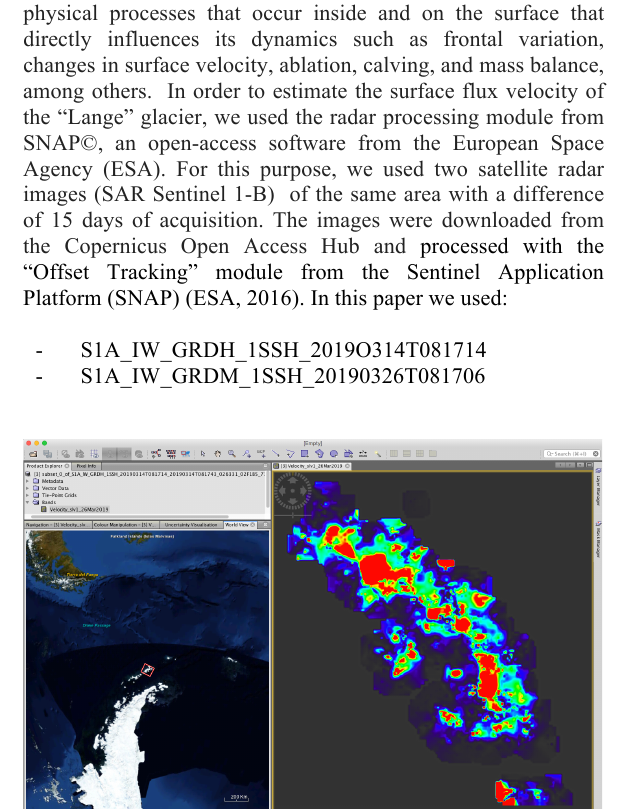
Figure 3: Surface Velocity Flux by SNAP terrain correction over Google Earth (Lange glacier velocity in m/day).